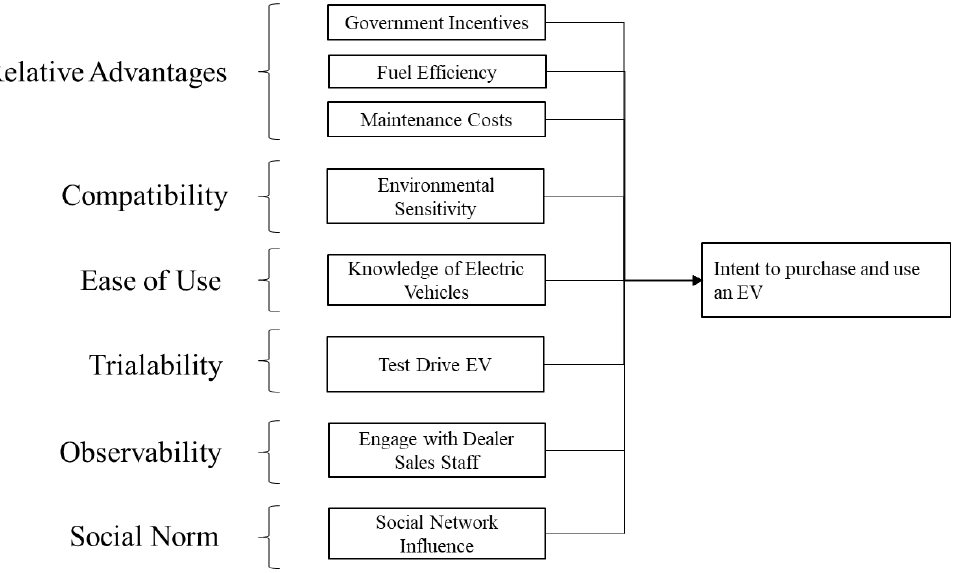
Figure 2. EV adoption model [adapted from Peters and Dütschke